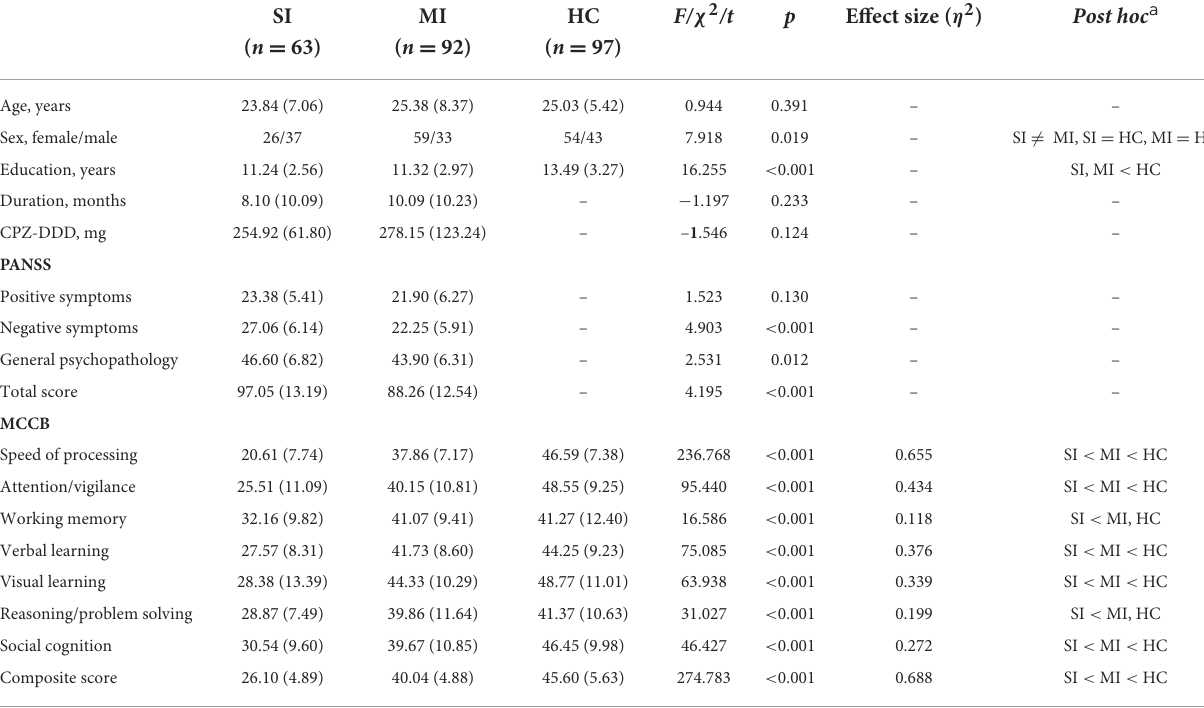
TABLE 2 Demographic and clinical data of ECS cognitive subtypes and